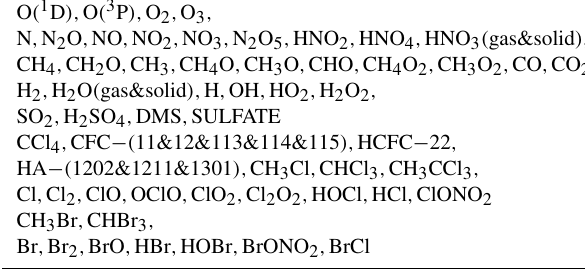
Table 1. List of species used for the box-model simulations. The upper part of the table lists the species active in the free troposphere and the stratosphere. The lower part lists additional VOC species or generic species involved in the RACM mechanism (Stockwell et al., 1997).